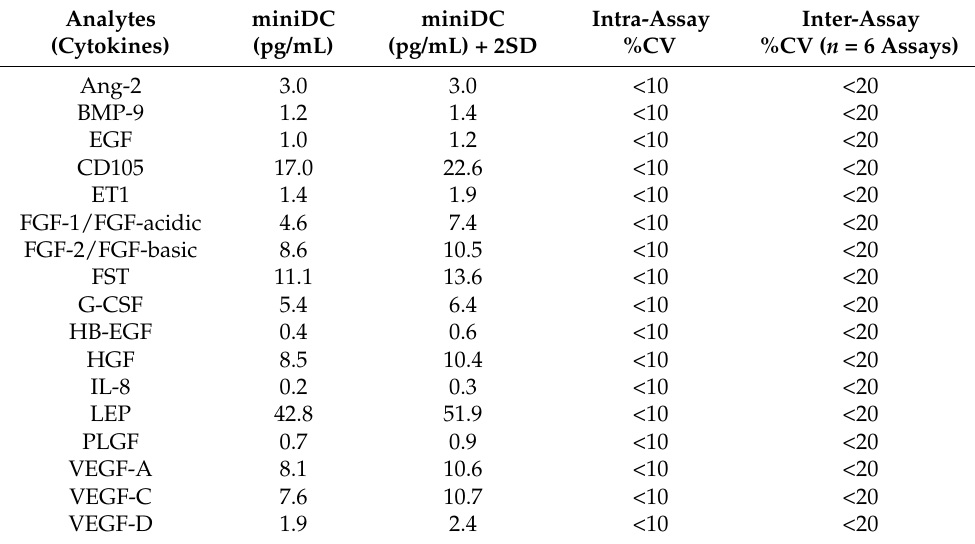
Table 1. Assay sensitivities and precision of investigated circulating biomarkers as reported by MerckMillipore HAGP1MAG-12K kit. Intra-assay is generated from the mean of the % CV’s from eight reportable results across two different concentrations of analytes (cytokines) in a single assay. Inter-assay precision is generated from the mean of the % CV’s across two different concentrations of analytes across six different experiments. miniDC, minimum detectable concentrations pg/mL; SD, standard